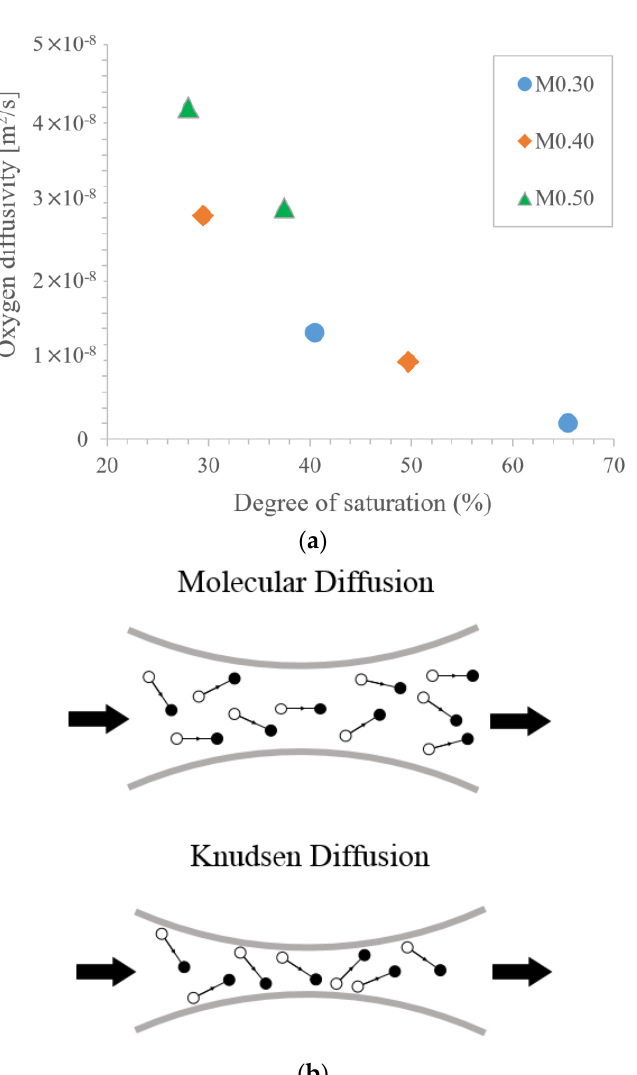
Figure 1. Gas diffusion properties, Chiara Villani et al., retouching [17]: ( a ) oxygen diffusivity as a function of the degree of saturation and ( b ) gas transport mechanism.